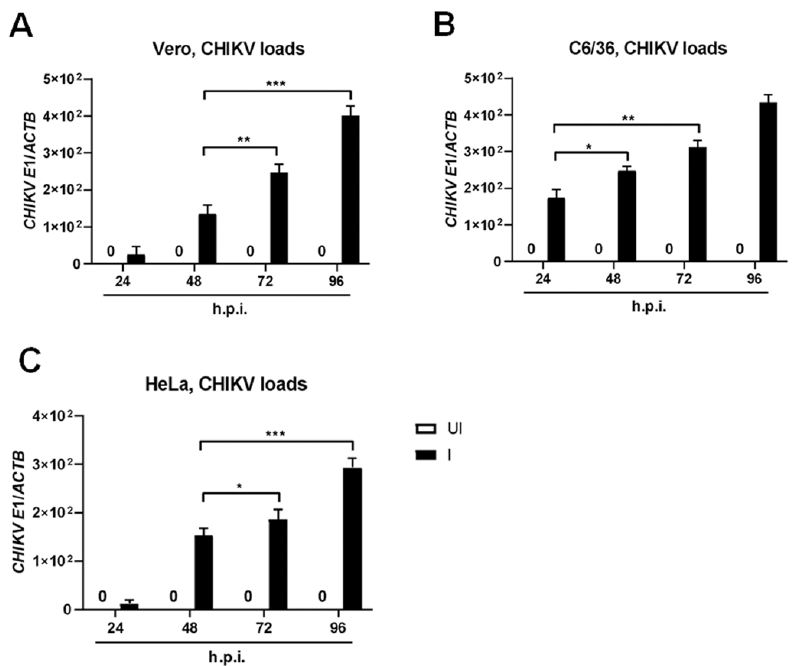
Figure 1. Kinetics infection of CHIKV ROSS C6D4 in various epithelial cell lines. qRT−PCR analysis showing transmembrane glycoproteins E1 mRNA loads in CHIKV-infected (MOI = 5) Vero cells ( A ), C6/36 cells ( B ), or in HeLa cells ( C ) at indicated time points. Each parental-uninfected cell type was used as a control. UI, CHIKV-uninfected cells; I, CHIKV-infected cells; * , p < 0.05; ** , p < 0.01; *** , p < 0.0001.